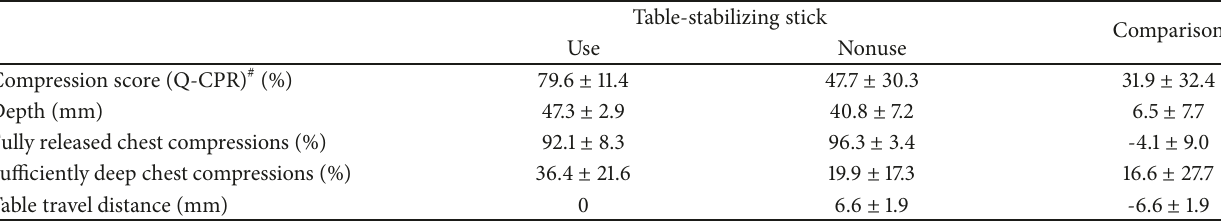
Table 1: Effect of the catheterization table-stabilizing stick on the quality of cardiopulmonary resuscitation (CPR).